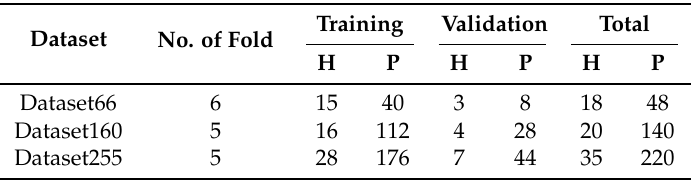
Table 2. Stratified cross validation (SCV) setting of all